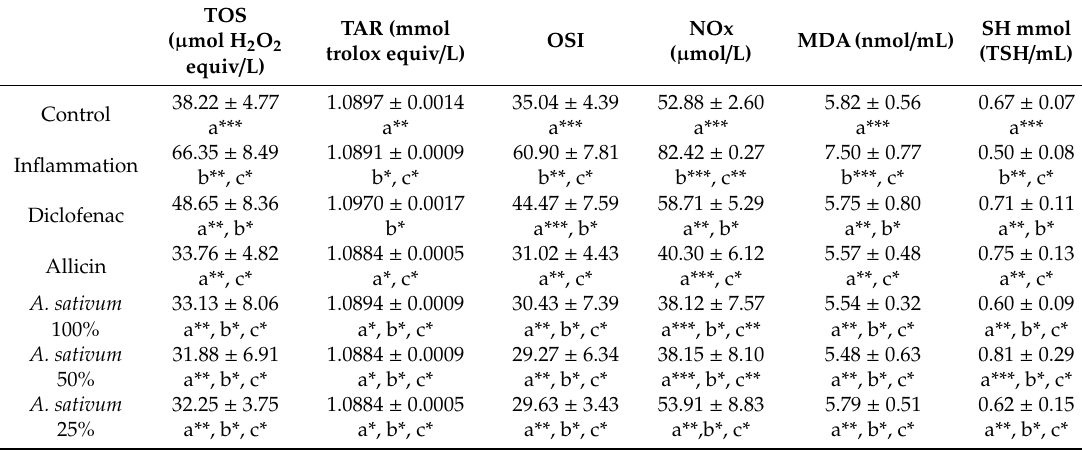
Table 3. In vivo serum oxidative stress